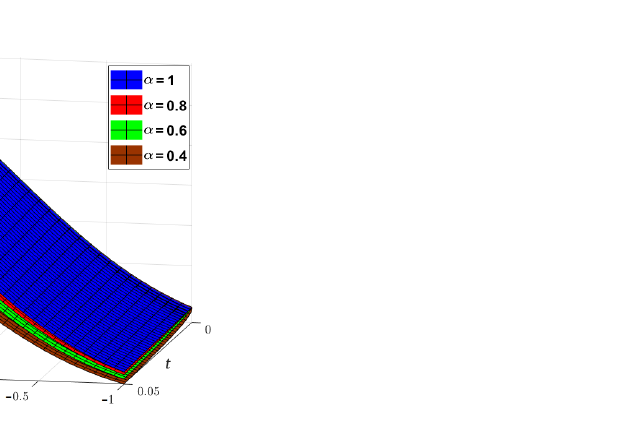
Figure 1. Three-dimensional plots of the approximate and exact solutions of U ( x , t ) (Example 1) using the LADM.